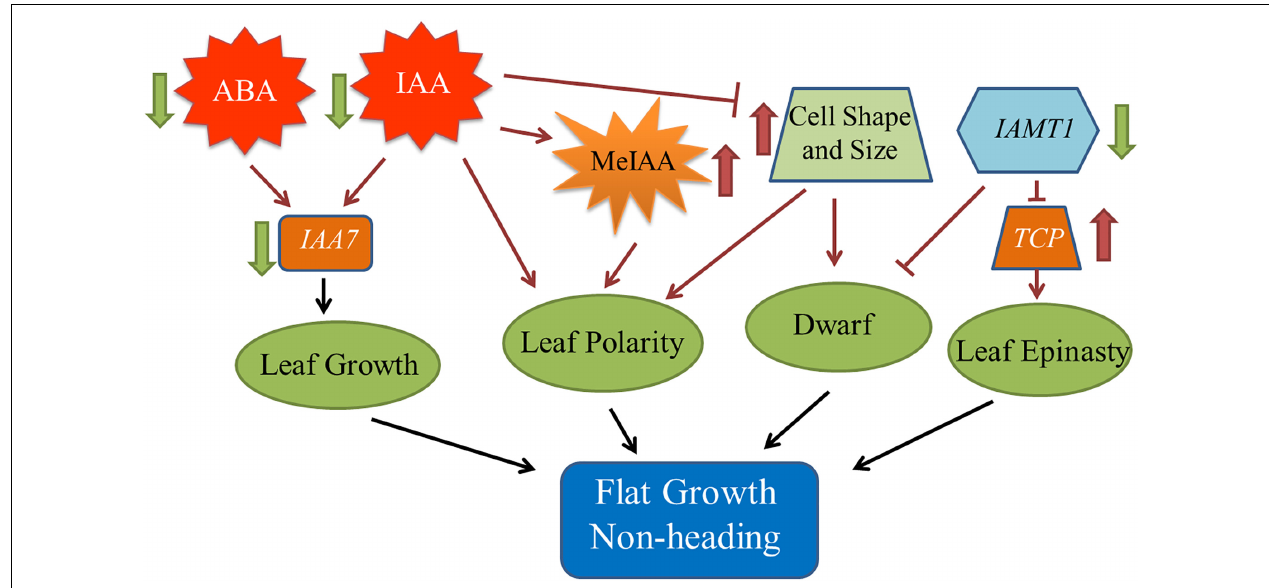
FIGURE 6 | Model of the regulatory network contributing to the fg-1 non-heading leaf phenotype. The black solid arrows denote the findings inferred from the present study. Dark red arrows denote the results of previous